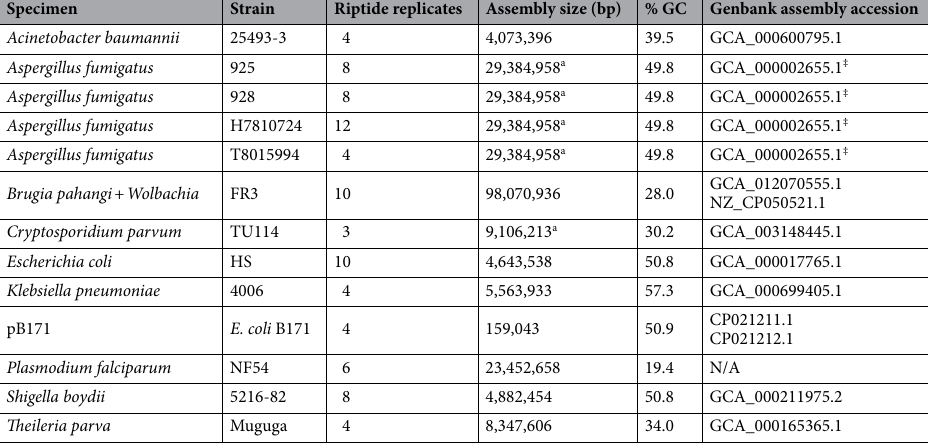
Table 1. Biological samples used in the study. a Assembly size includes gap regions. ‡ A. fumigatus Af293